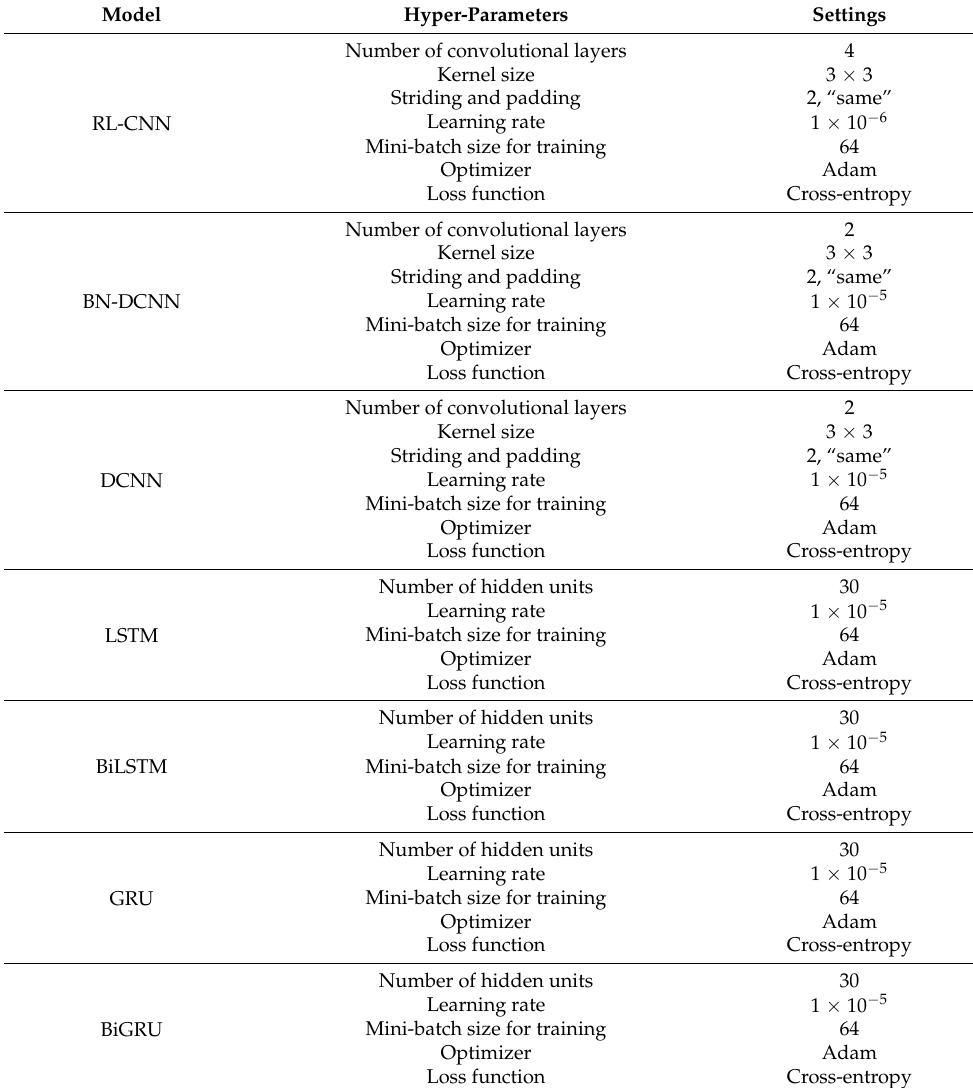
Table 4. The settings of the hyper-parameters of the proposed method and the compared methods.